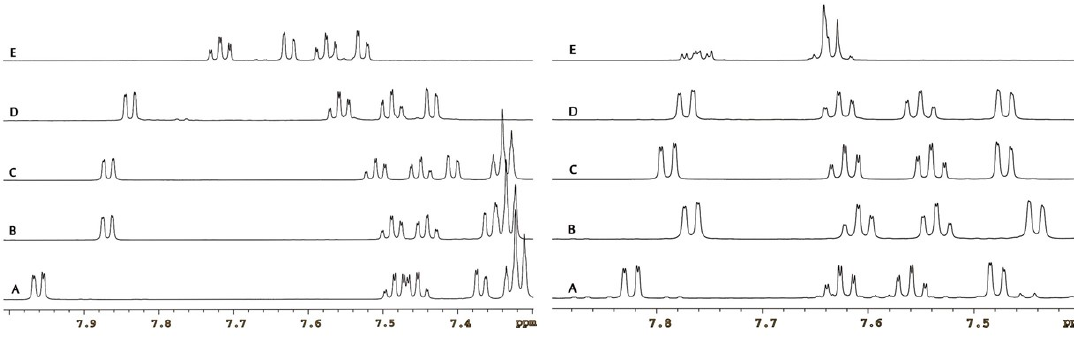
Figure 4. 1 H-NMR spectra of 2 (A), 3 (B), 6 (C), 9 (D) and 10 (E) in CDCl 3 solutions at 7.3–8.0 ppm range ( left ) and in DMSO- d 6 solutions at 7.4–7.9 ppm range ( right ).